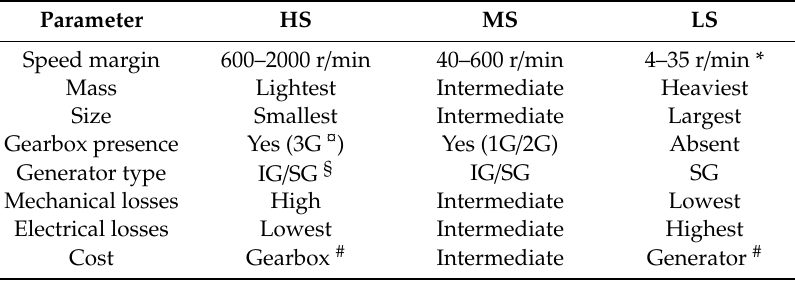
Figure 1. Global total installed capacity [1]. Table 1. Characteristics of wind turbine drive-trains [2].